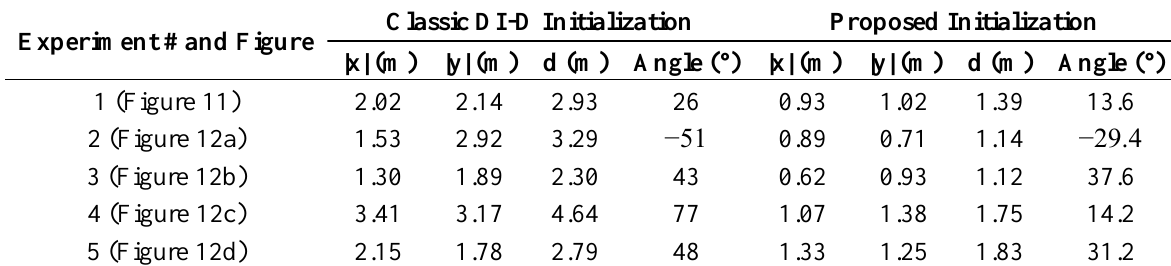
Table 1. Final pose estimation errors at the end of the trajectory.